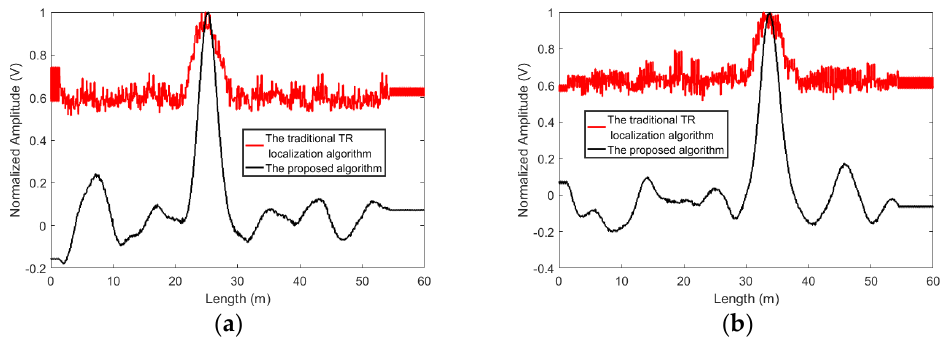
Figure 7. The localization results obtained by using the proposed algorithm and the traditional time reversal localization algorithm at SNR = −5dB, ( a ) L1 and ( b ) L2.